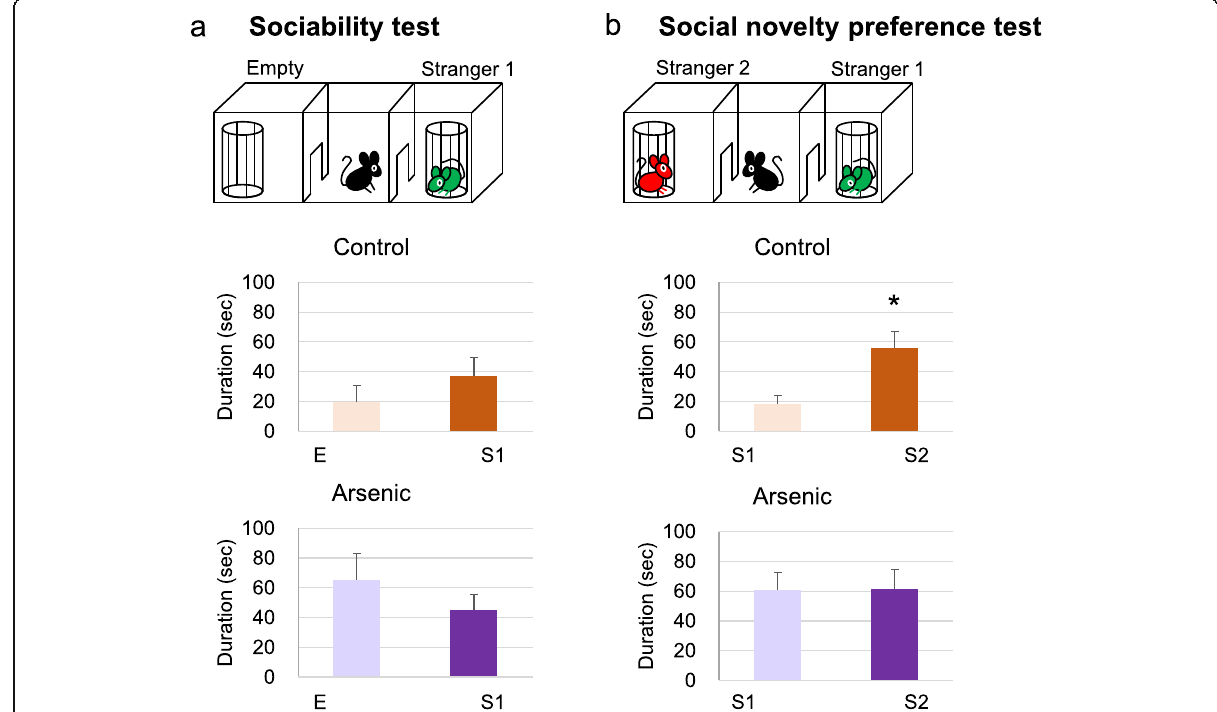
Fig. 2 Social behavior test at 41-week-old. a Sociability test and b social novelty preference test in the control group and the arsenic group of 41-week-old F2 male mice. Each bar represents the mean ± SE ( n = 9 – 12, * p < 0.05). E, empty; S1, stranger 1; S2, stranger